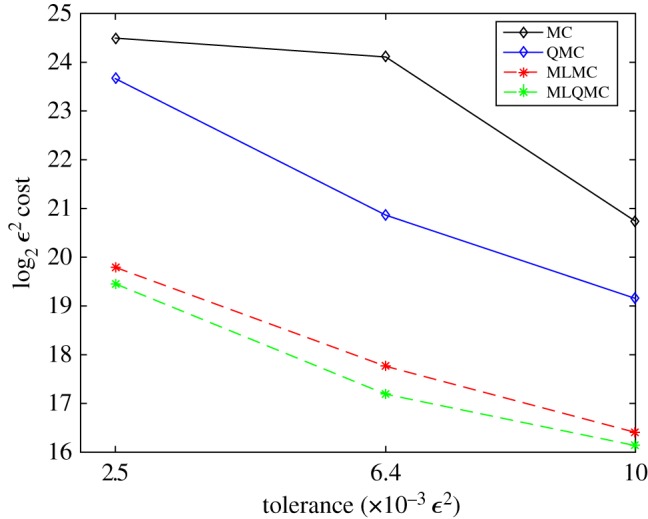
ε2-Cost for the MC, QMC, MLMC and MLQMC methods for MSE: 0.01, 0.0064 and 0.0025.